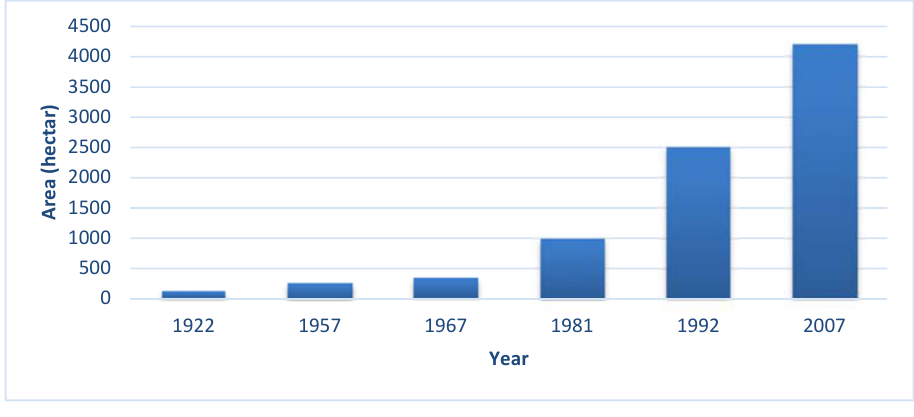
Fig. 1. Expansion of the city